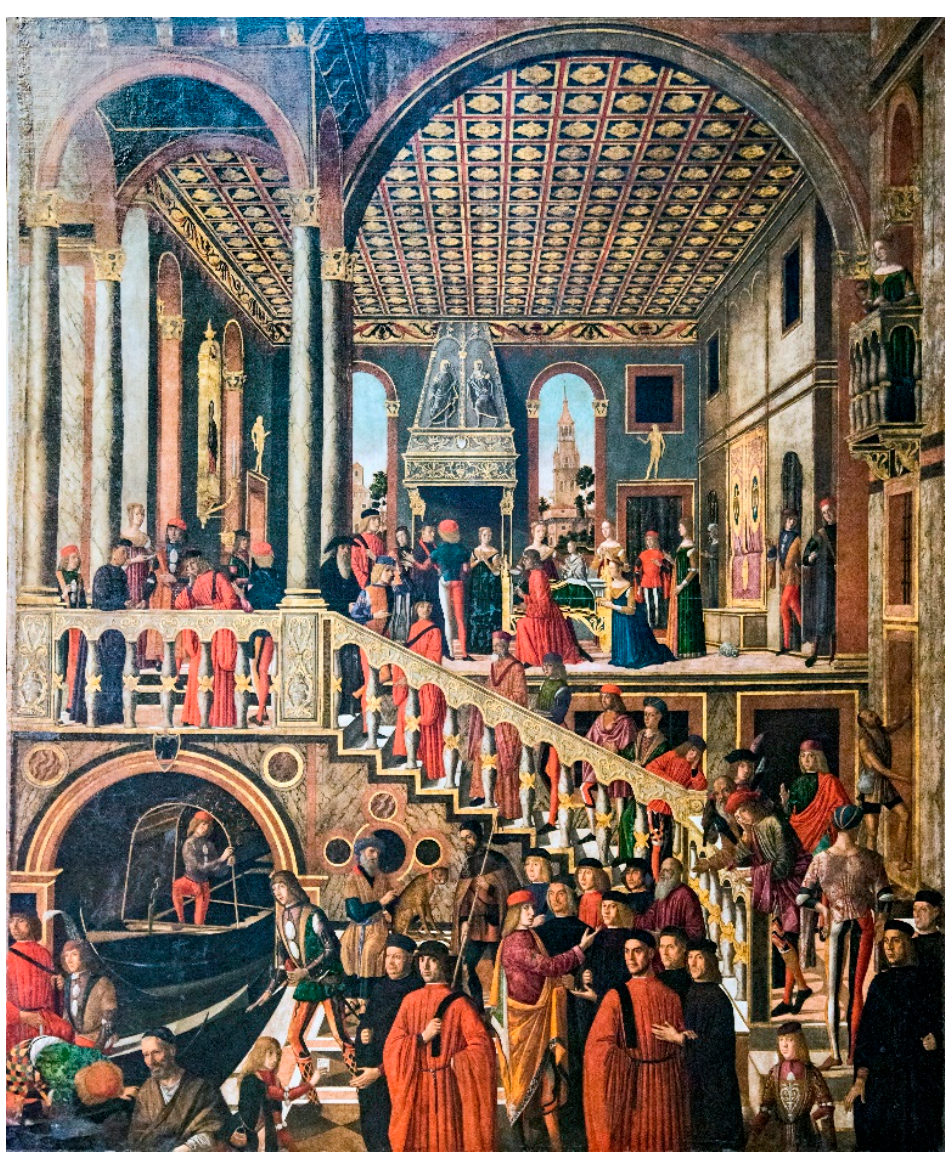
Figure 13. Giovanni Mansueti, The Miraculous Healing of the Daughter of Benvegnudo of San Polo, ca. 1505, Venice, Gallerie dell’Accademia (image in the public domain).